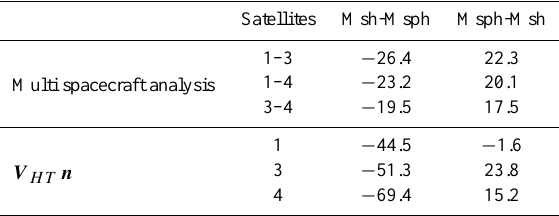
Table 3. Magnetopause velocity in km/s deduced from the time de- lays between different spacecraft crossings and from the projection of the dHT velocity along the magnetopause